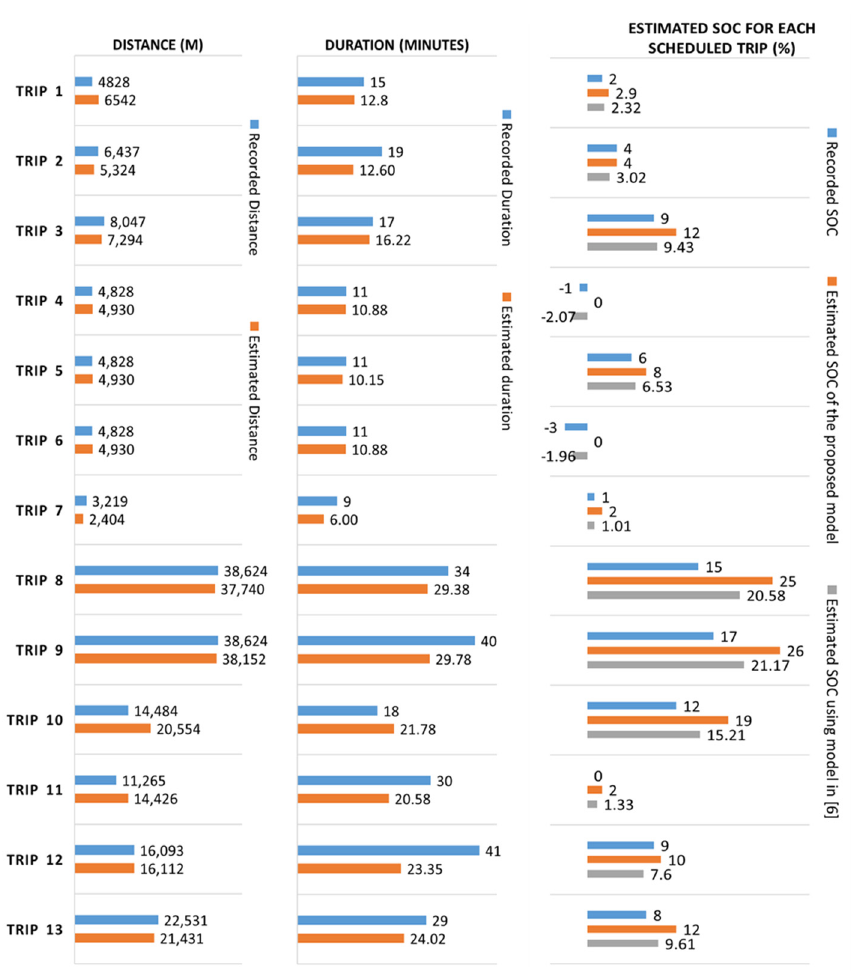
Figure 8. Comparison of the travel distances, travel times and SOC change for trips under test.